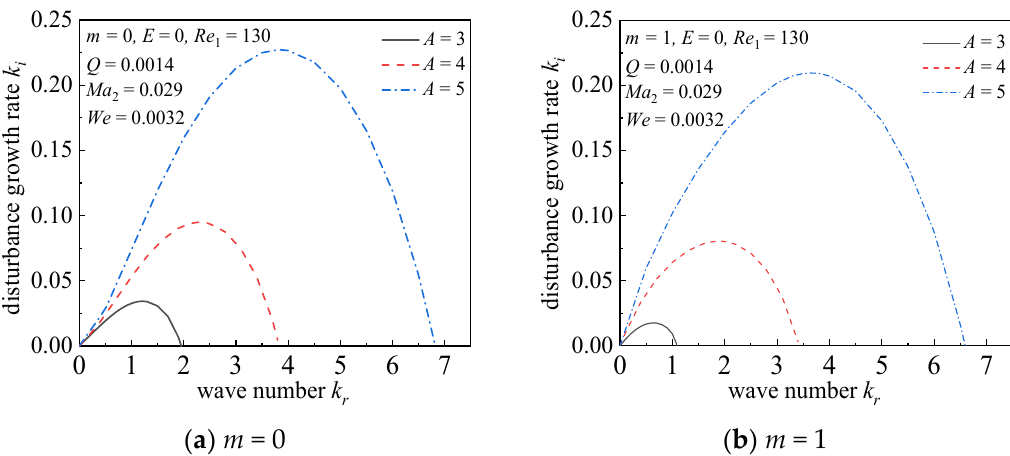
Figure 4. Comparison of the disturbance growth rates versus axial wave numbers under strong airflow ejection.